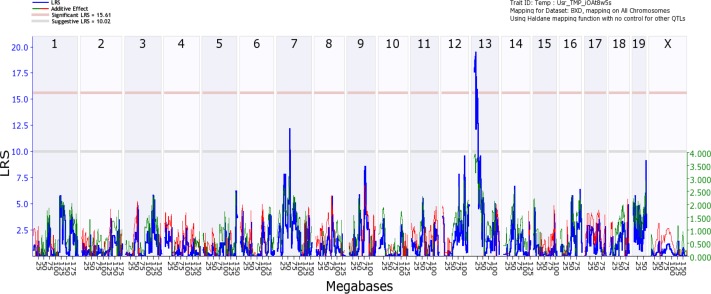
Interval map of CCT across the mouse genome is illustrated.The blue line indicates the total LRS score. The red line illustrates the contribution from the B6 allele and the green line the contribution from the D2 allele. The location across the genome is indicated on the top from chromosome 1 to chromosome X. On the y-axis is the linkage related score (LRS). Notice one significant QTL peak on Chr13 (above the pink Line, p = 0.05) and additional suggestive peaks (above the gray Line).